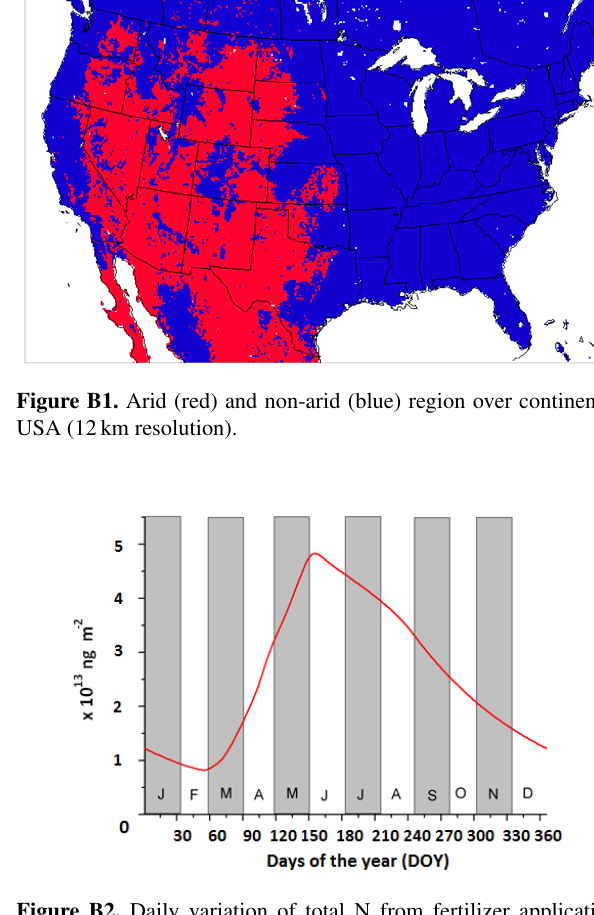
Figure B2. Daily variation of total N from fertilizer application (from Potter et al., 2010) processed from BDSNP to establish tim- ing over continental USA throughout 2011.